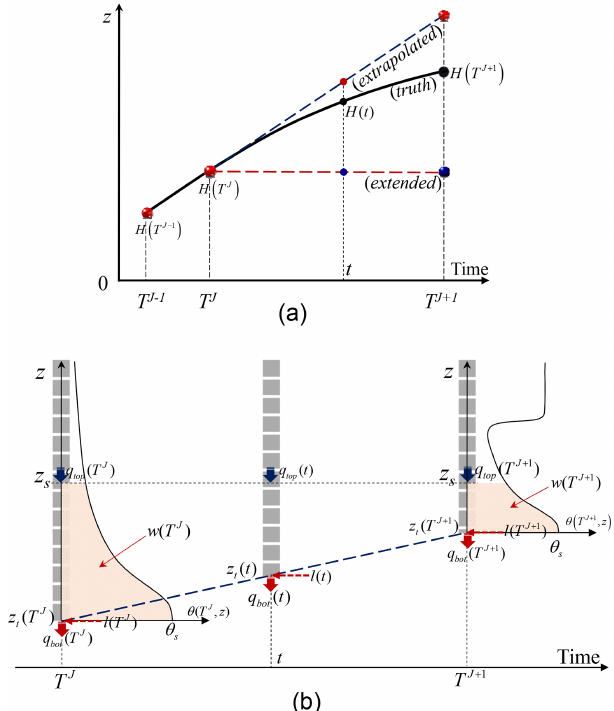
Figure 2. The Dirichlet–Neumann coupling of the soil-water and groundwater flow models at different scales. (a) Linear or step- wise prediction of Dirichlet lower boundary for the soil-water flow model. (b) Water balance analysis based on a balancing domain with moving lower boundary. Blue dashed line is the linearly extrap- olated groundwater table as an alternative for prediction of Dirichlet lower boundary. J (or j ), T (or t ), and (cid:49)T (or d t ) are the time level, time, and time-step size at coarse (or fine) scale. At any of the tran- sient states ( t ), the balancing domain is bounded by a user-specified top elevation ( z s ) and the moving phreatic surface ( z t ). At a tran- sient time t (or T J ) , the total mass volume in the moving balancing domain is indicated by w(t) (or w(T J ) ). The saturated lateral flux of the moving domain is indicated by l(t) , while the unsaturated lat- eral flux is neglected as the assumption of quasi-3-D models. The water flux into and out of the balancing domain is indicated by q top and q bot .